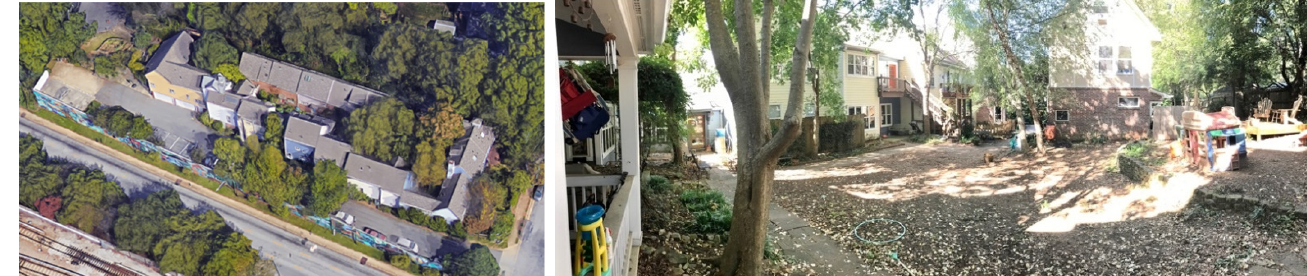
Figure 3. Lake Claire Cohousing. Its structure provides an inner play space for children and families.